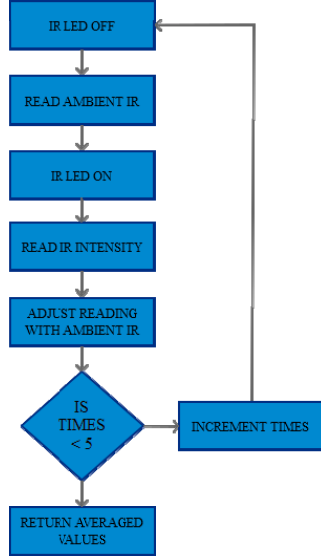
Figure 8. Block diagram of drop count.